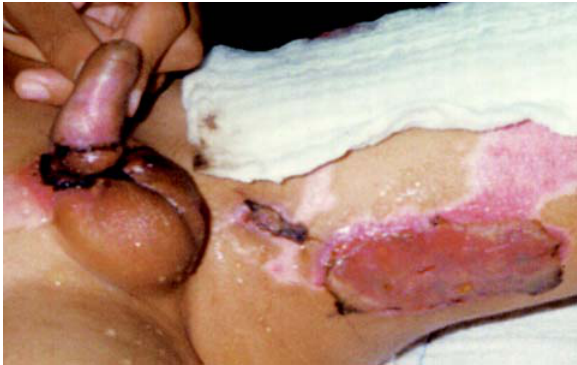
Figure 2 – Aspect of the genitalia 14 days after skin